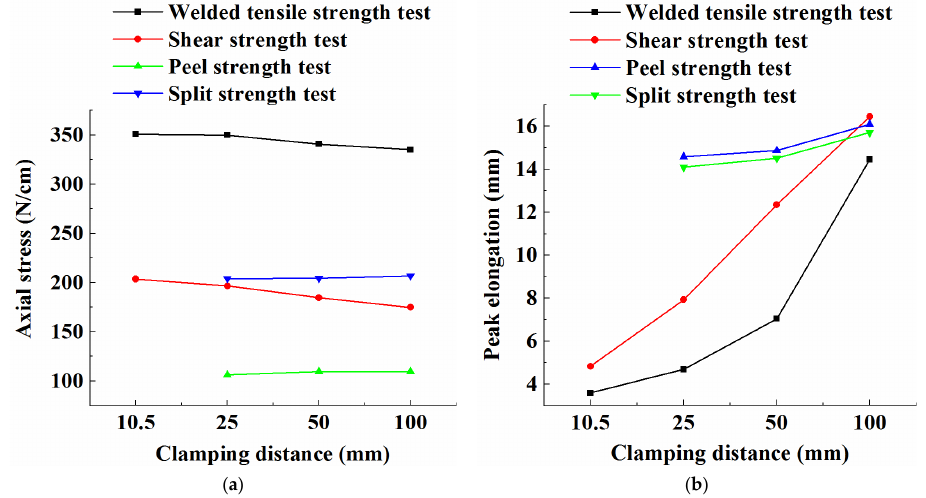
Figure 19. Junction test results under various clamping distances: ( a ) axial stress versus clamping distance; ( b ) pre-peak elongation versus clamping distance.